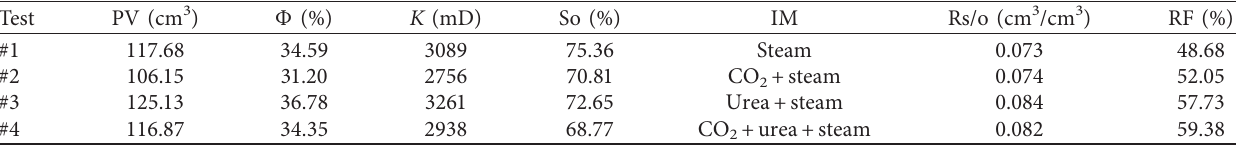
Table 3: Statistics of physical properties and displacement performance for different sand pack models.